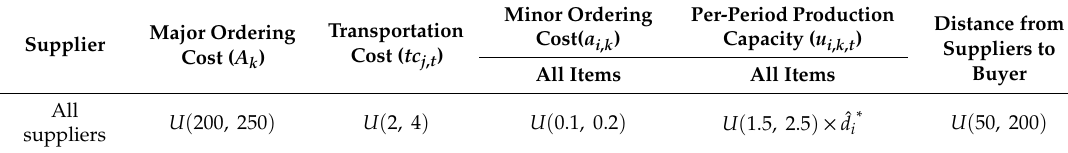
Table 4. Input parameters for suppliers.